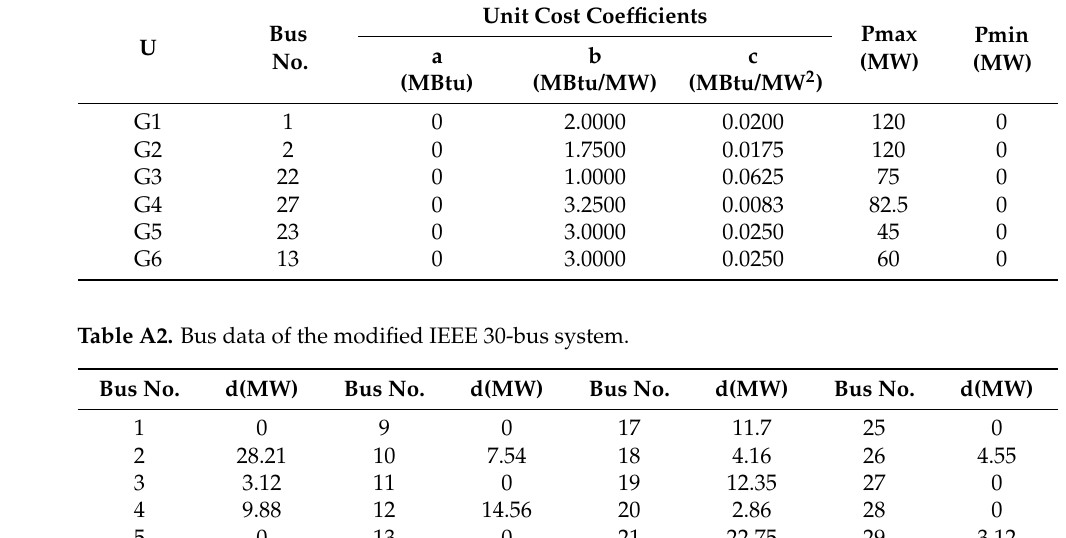
Table A1. Generator data of the modified IEEE 30-bus system.